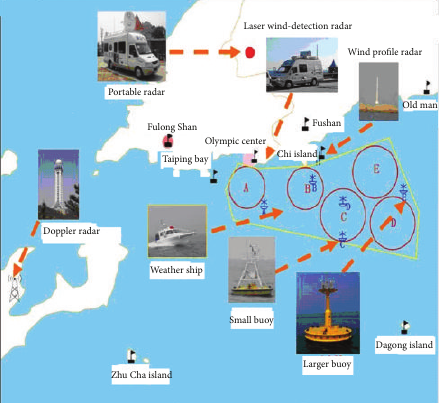
Figure 5: Schematic of the observational system for the sailing